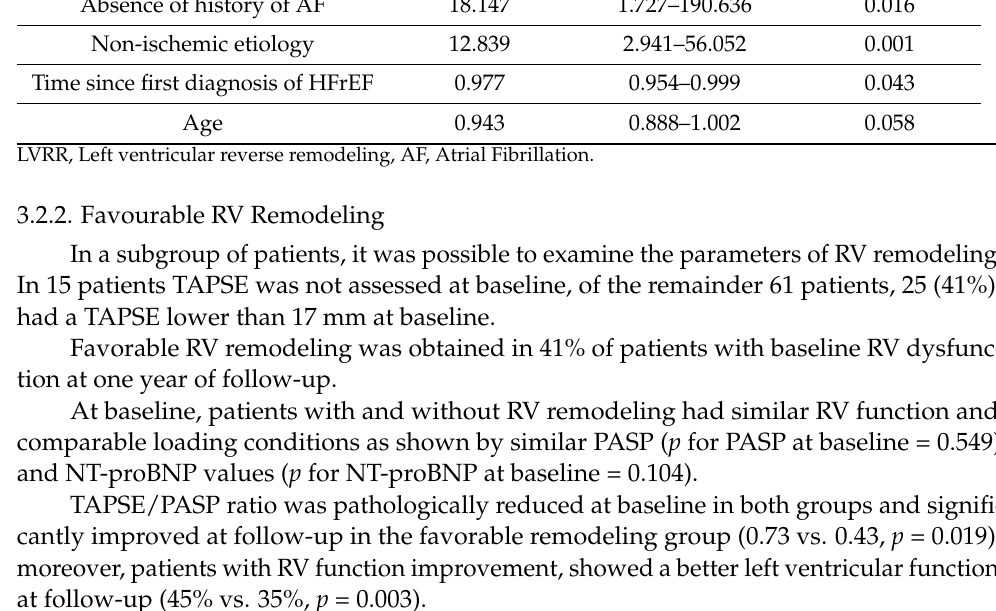
Table 4. Logistic regression analysis, with LVRR as the dependent variable. LVRR OR 95% CI p Value Absence of history of